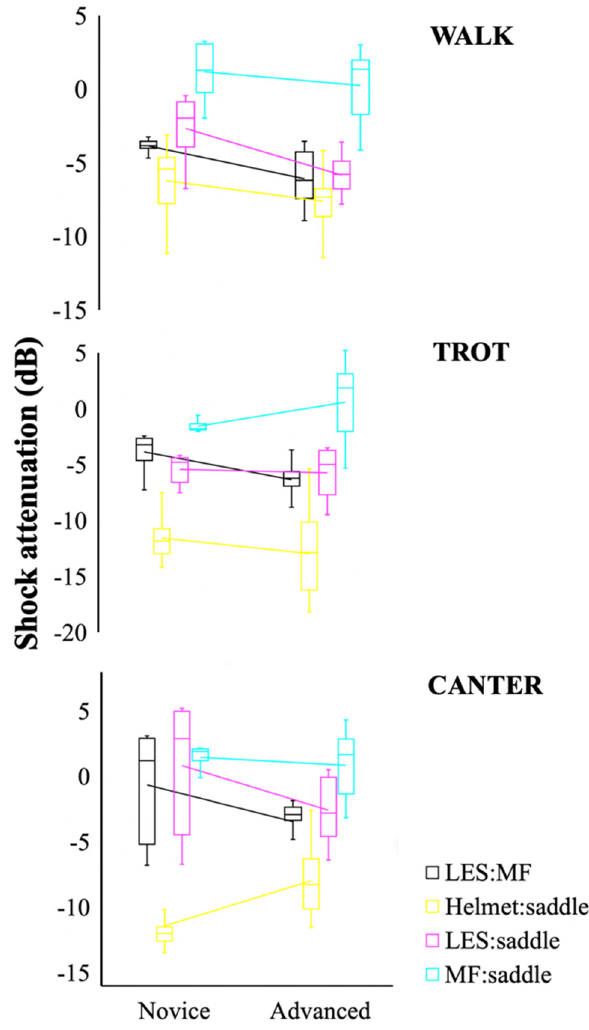
Figure 2. Summary data of overall shock attenuation at (A) walk, (B) trot and (C) canter in novice and advanced riders. Negative values represent attenuation whereas positive values indicate an increase in signal strength.